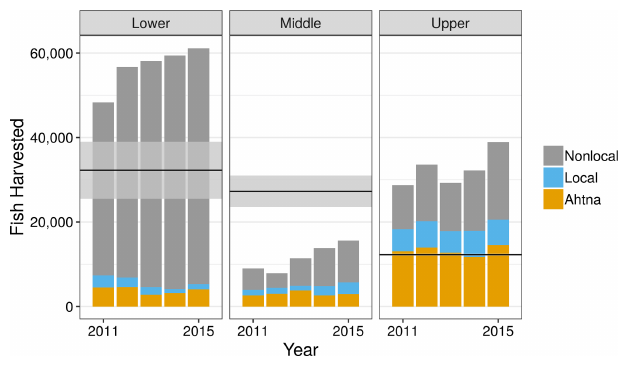
Fig. 8 . Harvest and amount necessary for subsistence (ANS) levels (shown as black line) for Glennallen subdistrict river sections (lower, middle, and upper) by community residency,